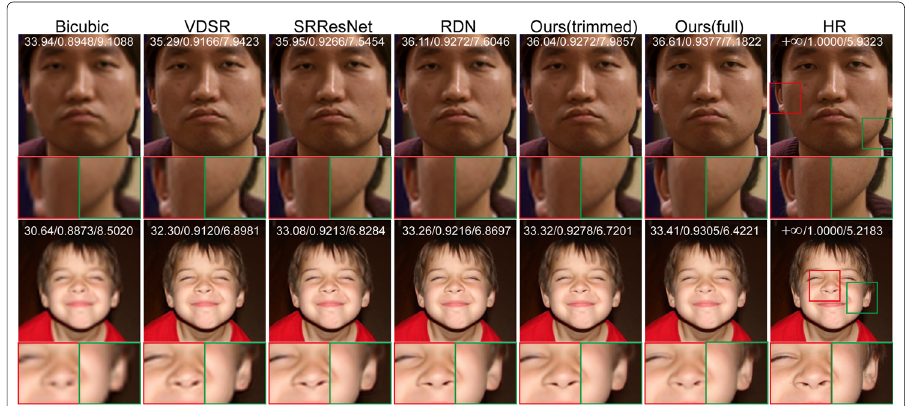
Fig. 8 Qualitative results. Two examples with the individual quantitative metrics from the FRGCv2.0 dataset (upper) and FFHQ dataset (lower), respectively. Please zoom in and pay attention to the sharpedges achieved by the proposed network